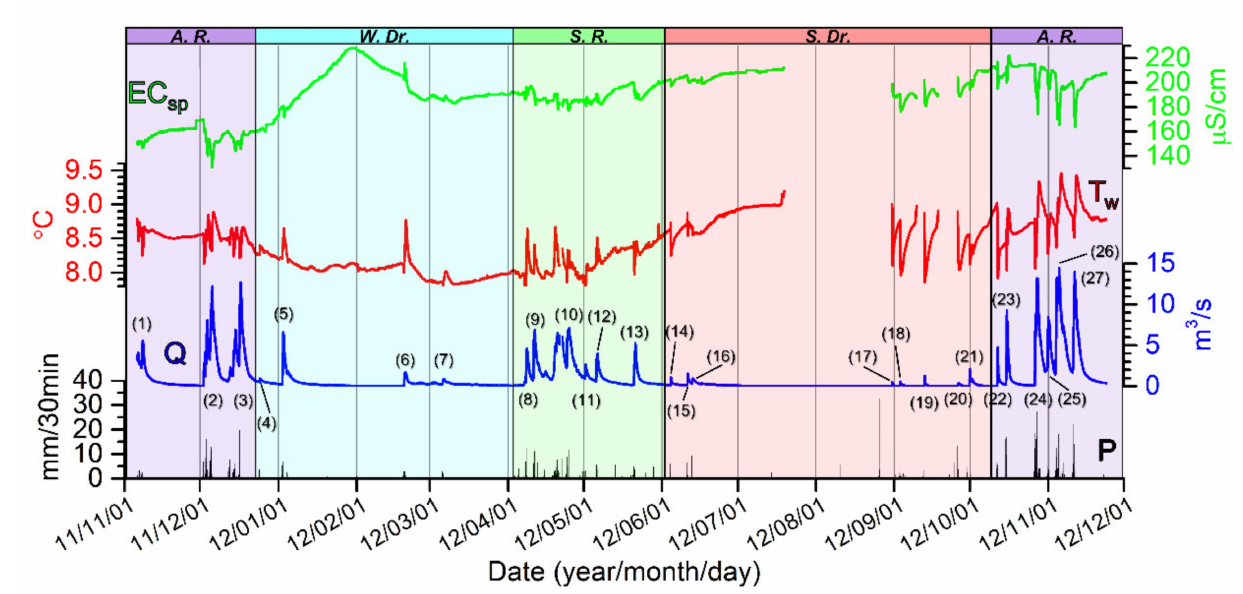
Figure 4. HTC-graph (Q–T w –EC sp ) of the Pollaccia spring. Precipitation data (P) were taken at the Campagrina meteorological station. The colors highlight the different hydrological phases: purple, cyan, green, and red represent the autumn recharge (A.R.), the winter drought (W.Dr.), the spring recharge (S.R.), and the summer drought (S.Dr.) phases, respectively. The numbers in brackets refer to the storm hydrographs analyzed for this